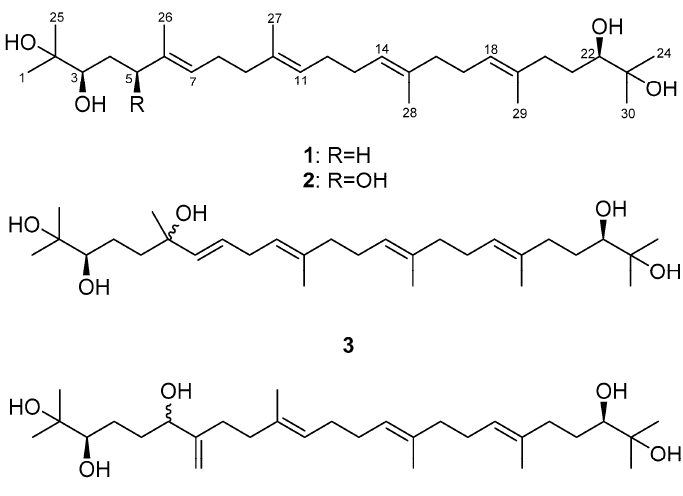
Figure 1. Chemical structure of Compounds 1 – 4 .